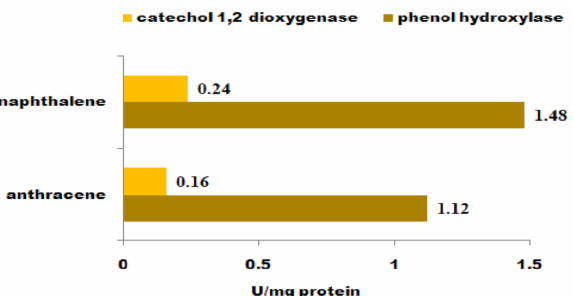
Figure 7. Enzyme activities of phenol 2-monooxygenase and catechol 1,2-dioxygenase in cells of Aspergillus glaucus AL1, cultivated in a Czapek Dox mineral medium containing 0.3 g/L naphthalene or 0.3 g/L anthracene as a sole carbon